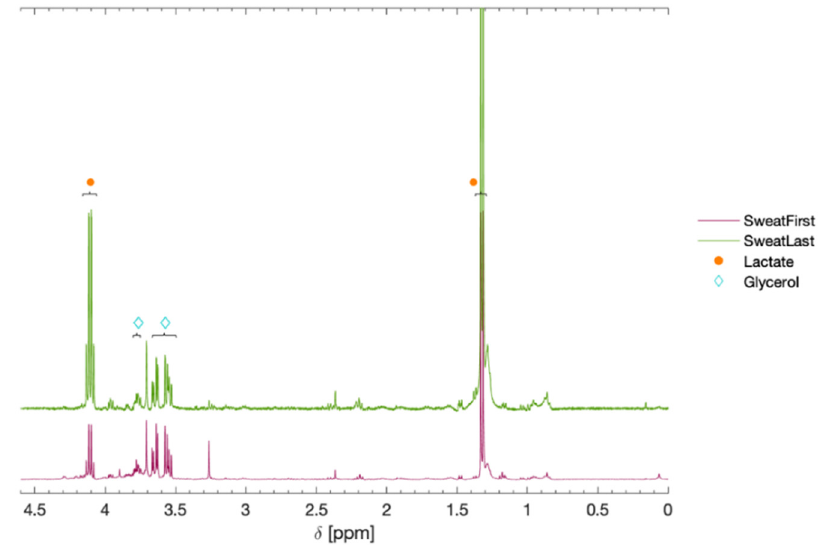
Figure 7. The 400 MHz 1 H-NMR spectra of human sweat taken directly after (SweatFirst), as well as after 15 min (SweatLast), following a 5 min exercise regime. The spectra show a significant difference for the lactate (orange circles) in the two samples, but also a distinct presence of glycerol (turquoise diamonds).